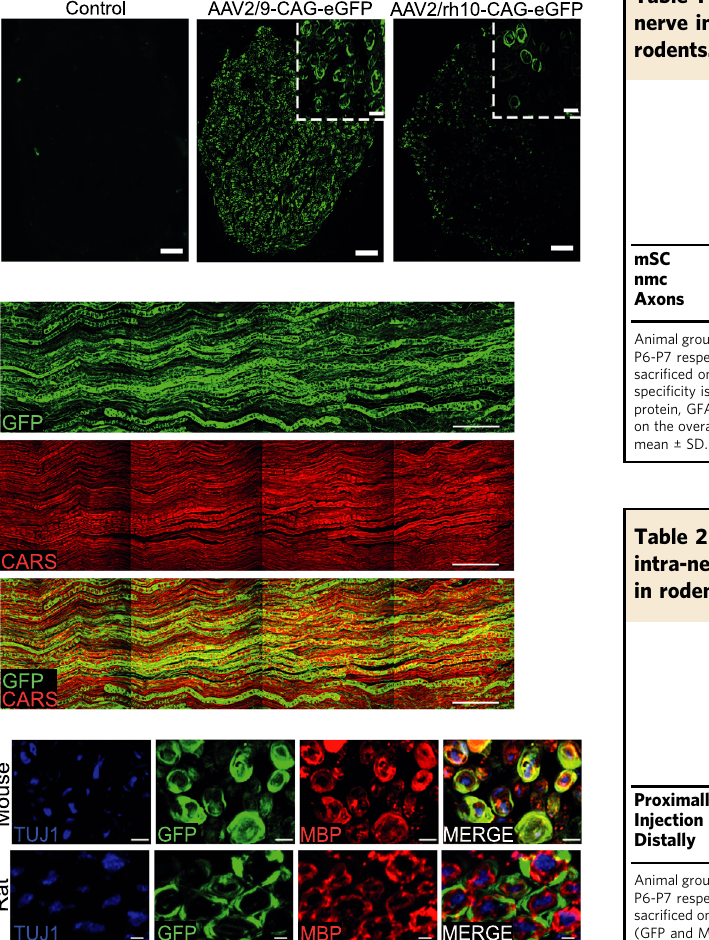
Table 1 Speci fi city of the transduction pattern after intra-